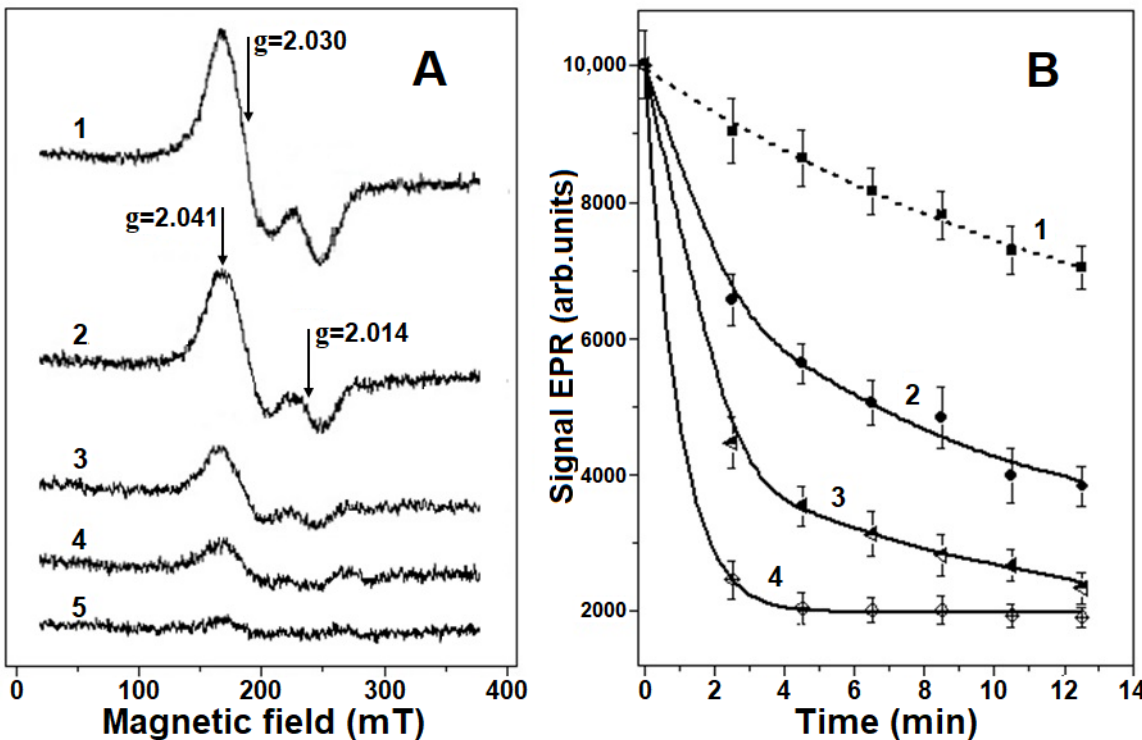
Figure 2. Destruction of metHb-bound dinitrosyl iron complexes (Hb-DNICs) with peroxynitrite (ONOO − ). The reaction mixture contained 0.2 M Na, K-phosphate buffer (pH 7.2) and 0.4 mM Hb-DNICs (Hb concentration). ( A )—typical electron paramagnetic resonance (EPR) spectra recorded 4.5 min after adding various peroxynitrite concentrations to the reaction mixture: 1—Hb-DNICs without peroxynitrite, 2—Hb-DNICs + 1.25 mM (1:3.2), 3—Hb-DNICs + 2.5 mM ONOO − (1:6.25), 4—Hb-DNICs + 4.8 mM ONOO − (1:12), 5—Hb-DNICs + 5.8 mM ONOO − (1:14.5), the molar ratio of Hb or Hb-DNICs to ONOO − is shown in parenthesis. ( B )—kinetics of Hb-DNICs degradation with the action of various ONOO − concentrations (results of five